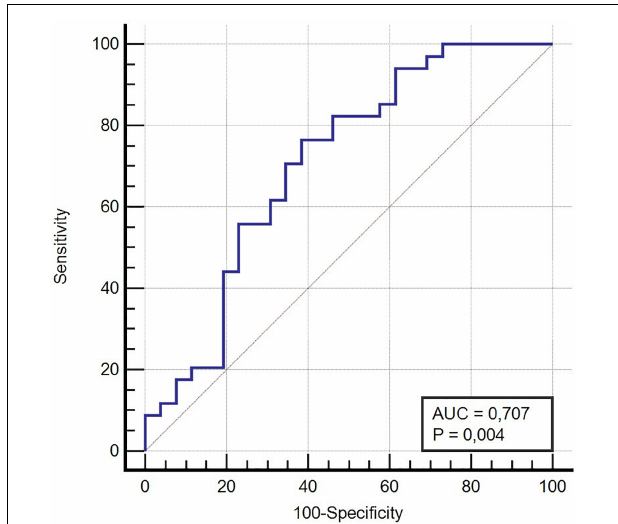
FIGURE 2 | ROC Curve COVID-19 Clinical Diagnosis and mitochondrial membrane potential variation ( (cid:49) ψ ), Area Under the Curve